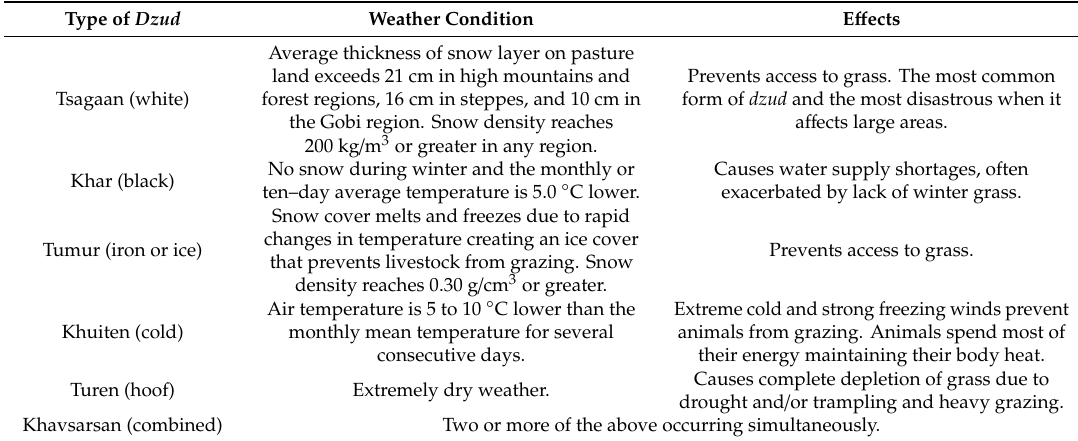
Table 1. Types of dzuds in Mongolia and their local nomenclature